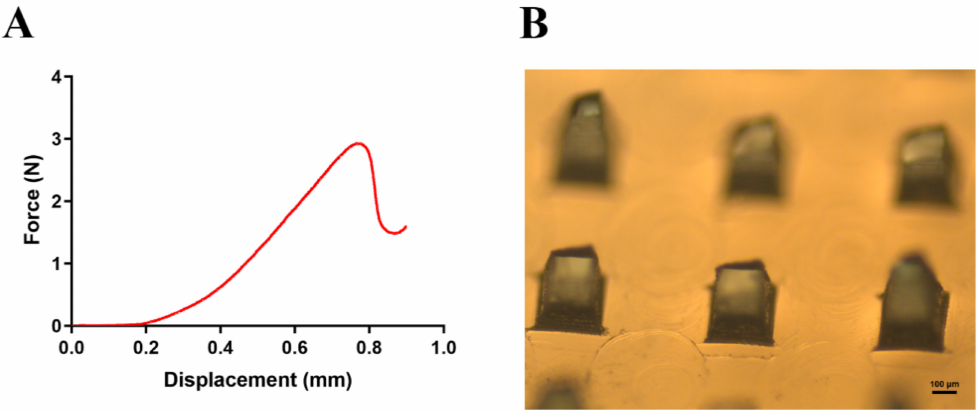
Figure 3. ( A ) The force-displacement curve of the microneedles. ( B ) The morphology of the microneedles treated by texture analyzer when the force dropped